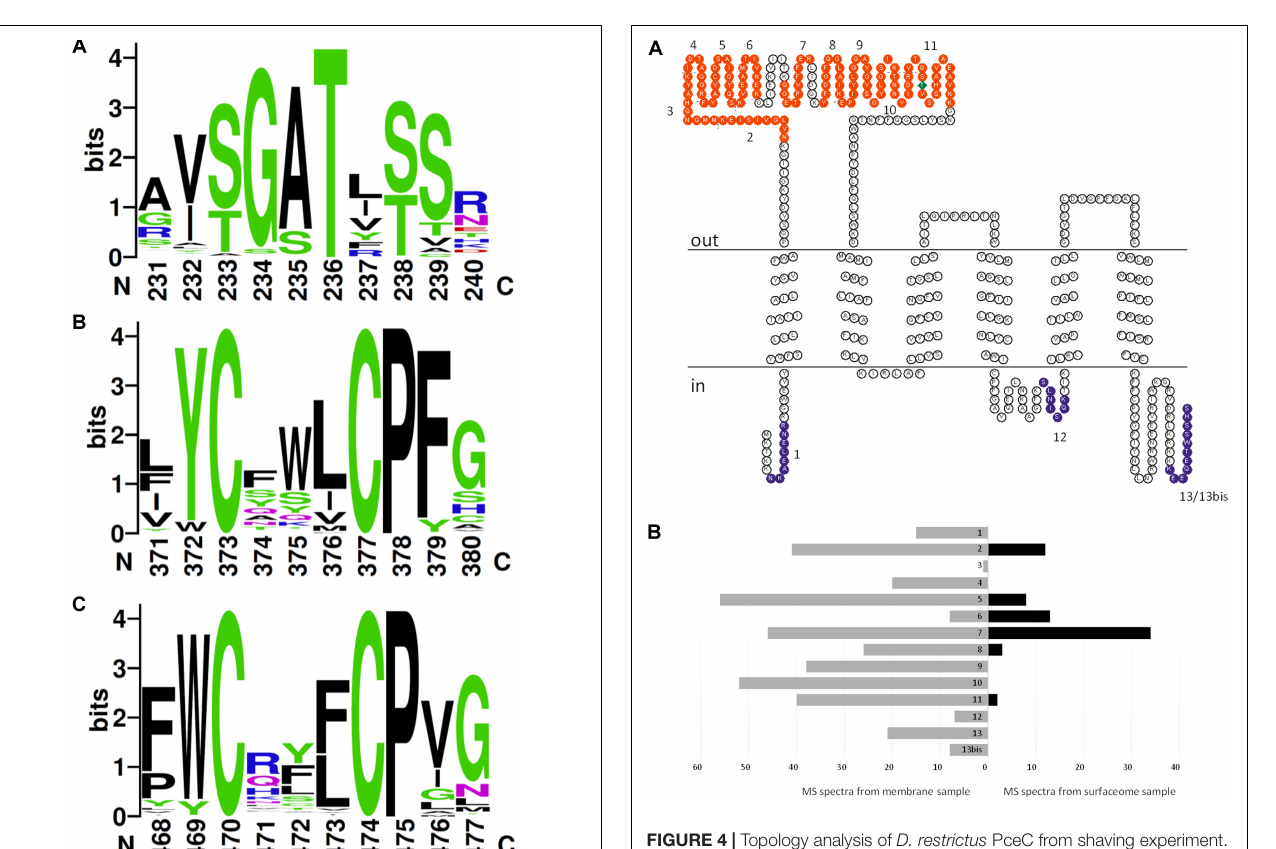
FIGURE 4 | Topology analysis of D. restrictus PceC from shaving experiment. (A) The predicted topology of PceC is shown. In red are indicated the peptides detected at the surface of D. restrictus cells, while in purple the ones exclusively detected in the membrane sample. (B) Graphical view of the number of detected peptides in the membrane sample (in gray) and in the surfaceome (in